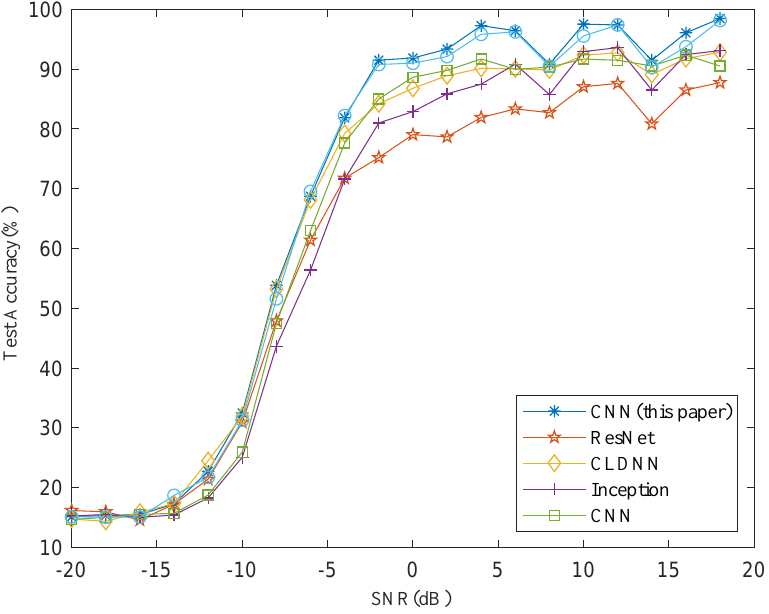
Figure 9. Classification accuracy over different SNRs.